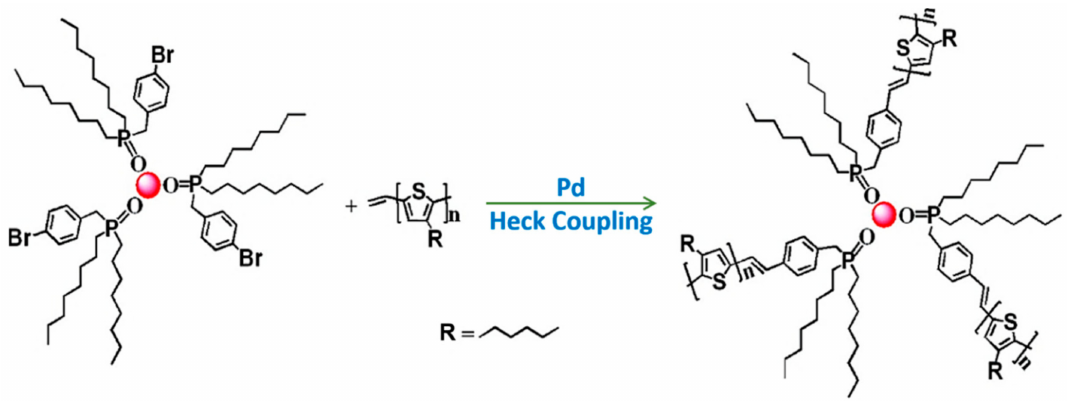
Figure 7. Schematic illustration of ligand exchange and grafting of end-functionalized CPs onto NCs. Reprinted with permission from [24]. Copyright 2007 American Chemical